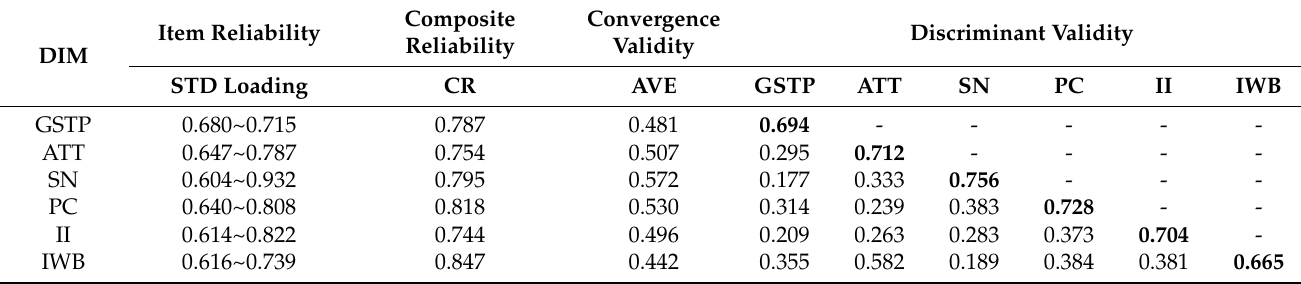
Table 2. Reliability, convergence validity, and discriminate validity